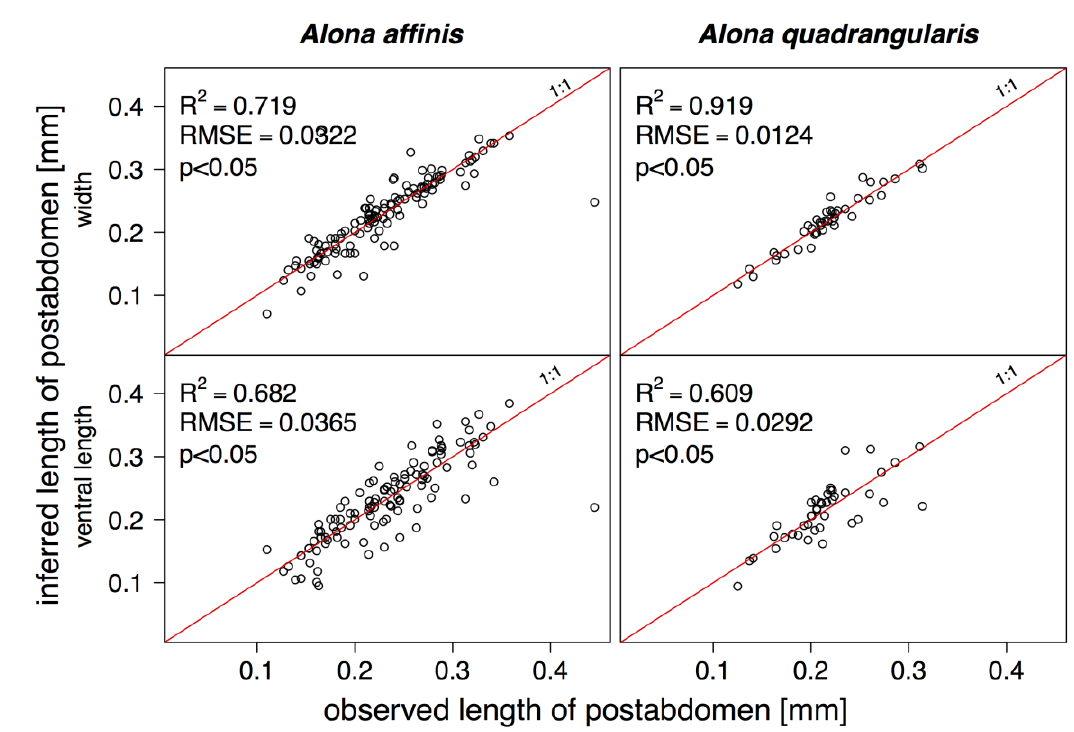
Figure A2. Inferred postabdomen length of Alona species.